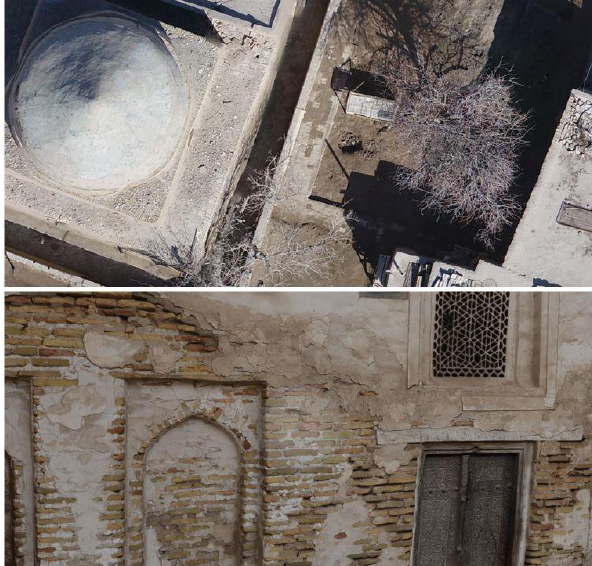
Figure 5. Detail of orthophoto of the roof and dome (upper) and detail of the 3D model of the north interior façade (bottom) of Bogbonli Mosque. Source: authors.